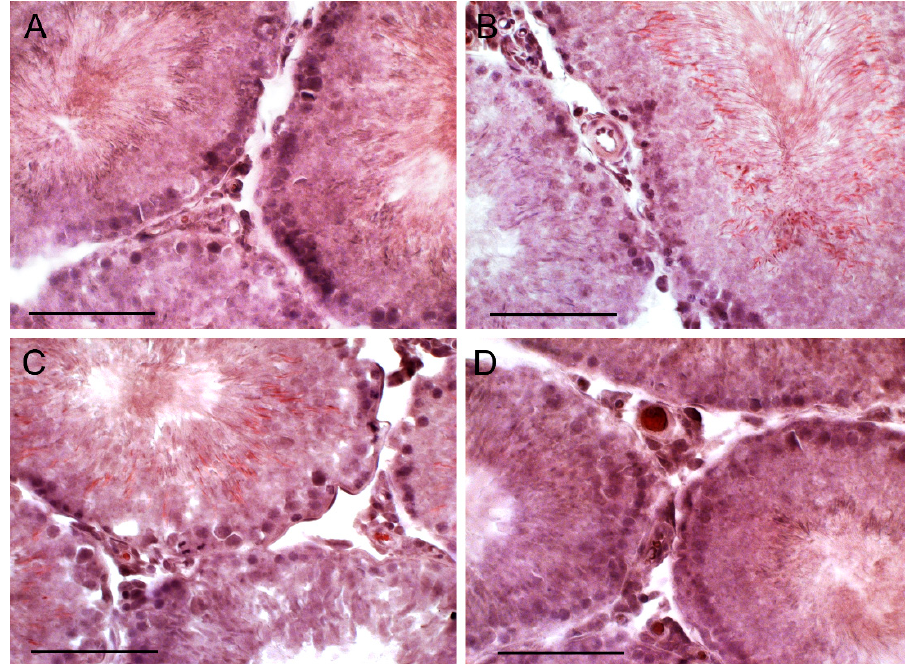
Figure 5. The morphology of the seminiferous tubules in the testis of young adult rats, and the effect of five-day treatment with TP4/2 and hCG. A —Young+dmso, B —Young+TP, C —Young+saline; D — Young+hCG. The histology of the rat testes was evaluated using the staining of the testis section with Ehrlich hematoxylin and Eosin G. Scale bars, 100 μ m.